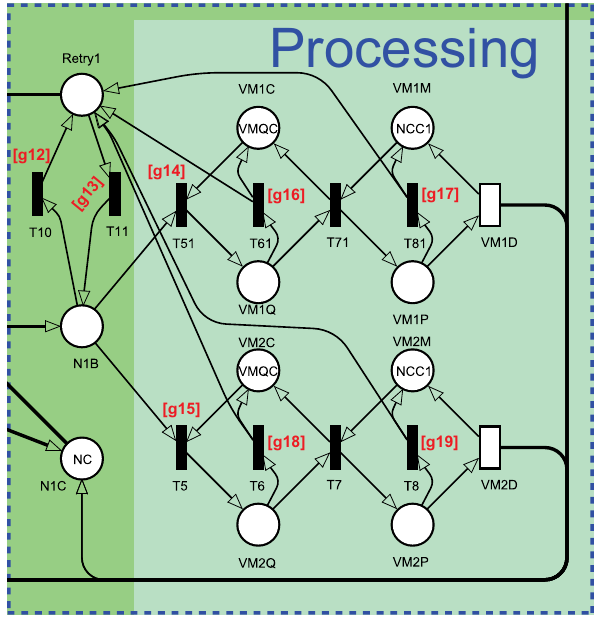
Figure 6. Processing submodule representing the virtual machines queues and processing capacities.